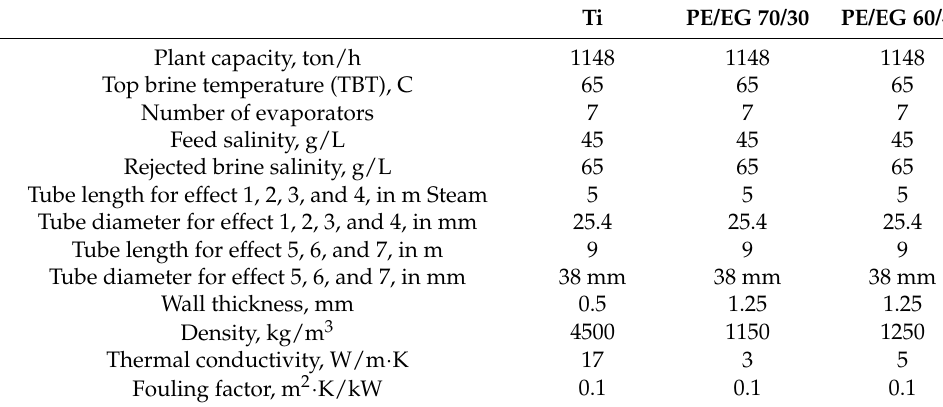
Table 1. Input modeling parameters for MED plant